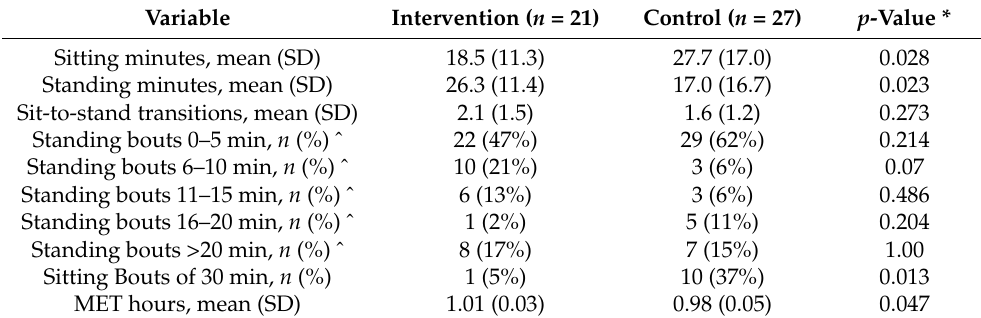
Table 2. Standing and sitting time of study participants during the 50 min lecture for those with ActivPAL data.